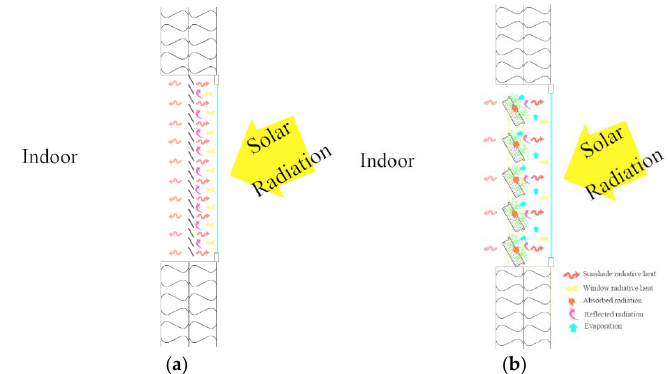
Figure 11. Louver ( a ) and MVGSD ( b ) shading heat